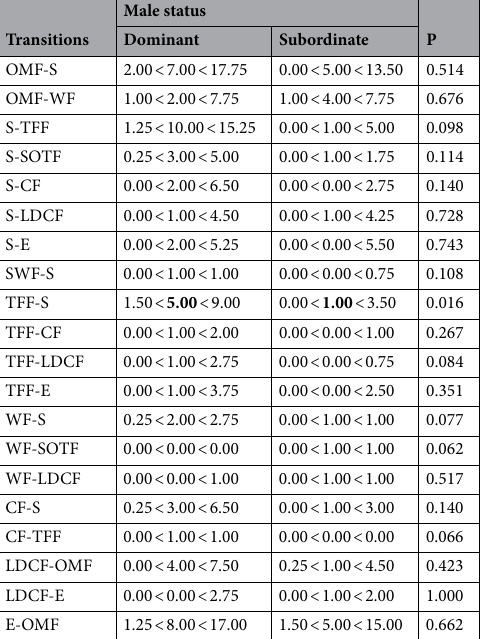
Table 5. Frequencies of transitions between the courtship behavioral elements of Anastrepha curvicauda dominant and subordinate (7–8 days old) males caged with a virgin 5–7 days old female. Choice experiment. Reported values are Q1 < Median < Q3 (n = 15). Medians in bold in the same row are significantly different (Mann–Whitney test, p > 0.05). See Table 1 for abbreviations.